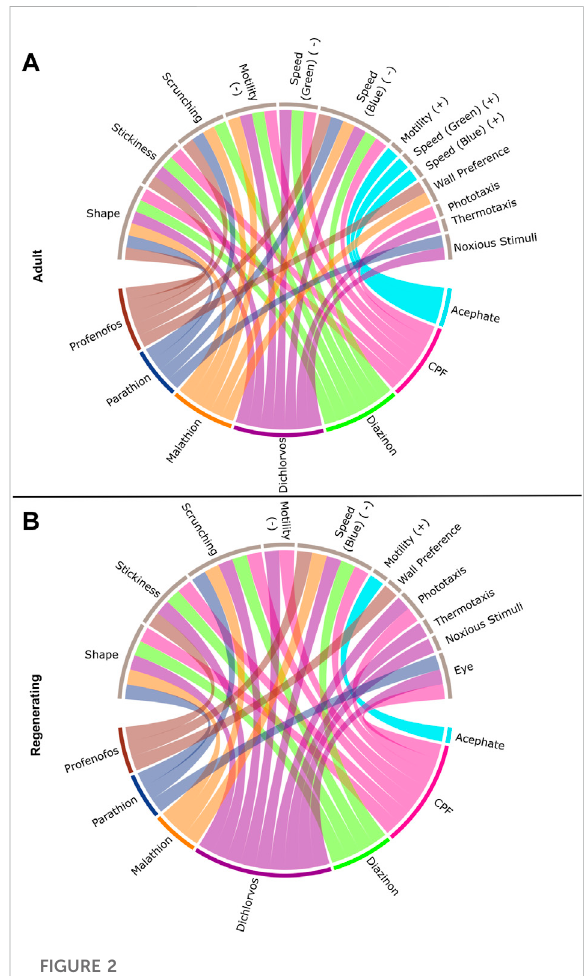
FIGURE 2 Connections between individual OPs and classes of endpoints.InteractionofthesevenOPswiththedifferentendpoint classes for (A) adult and (B) regenerating planarians. Connections were made if the OP caused a hit at either day 7 or 12 at any tested concentration. Effects on speed in the dark period, resting, or locomotor bursts were combined into the “ Motility ” category. Speed(B): speed in the blue period, Speed(G): speed in the green period, PT: Phototaxis, NS: noxious stimuli. For endpoints that had effects in both directions, the BMCs are separated by either the positive (+) or negative (-)